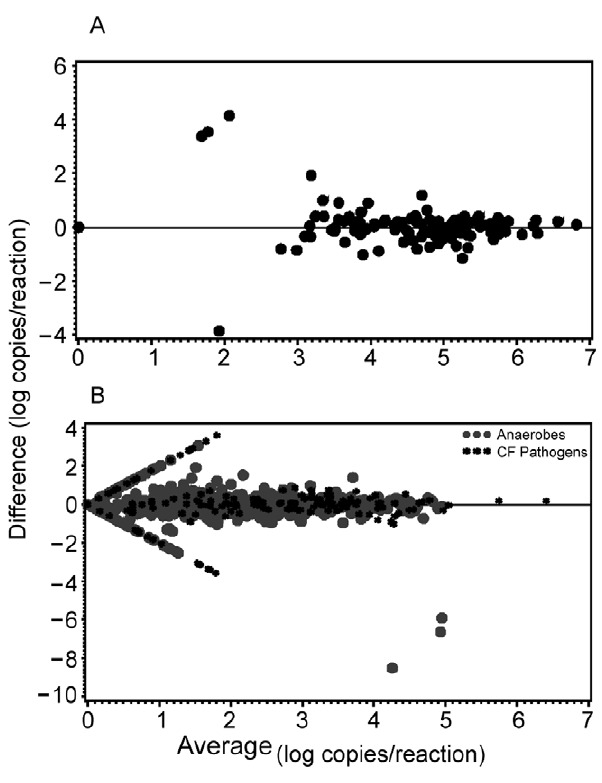
Figure 2. Relationship between qPCR reproducibility and quantity of bacterial DNA detected. Coefficient of Variation (CV) versus mean value of bacterial DNA (log 10 copies/reaction) detected in triplicate reactions for each DNA sample measurement for (a) bacterial load assay, n=277 sample measurements, and (b) specific organism assays, n=2216 sample measurements.